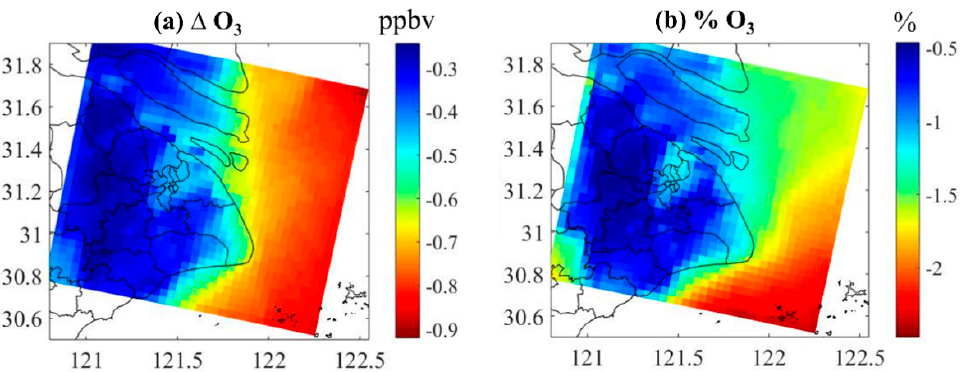
Figure 8. The ( a ) absolute and ( b ) relative contribution of DMS to the annual average concentration of O 3 in Shanghai.